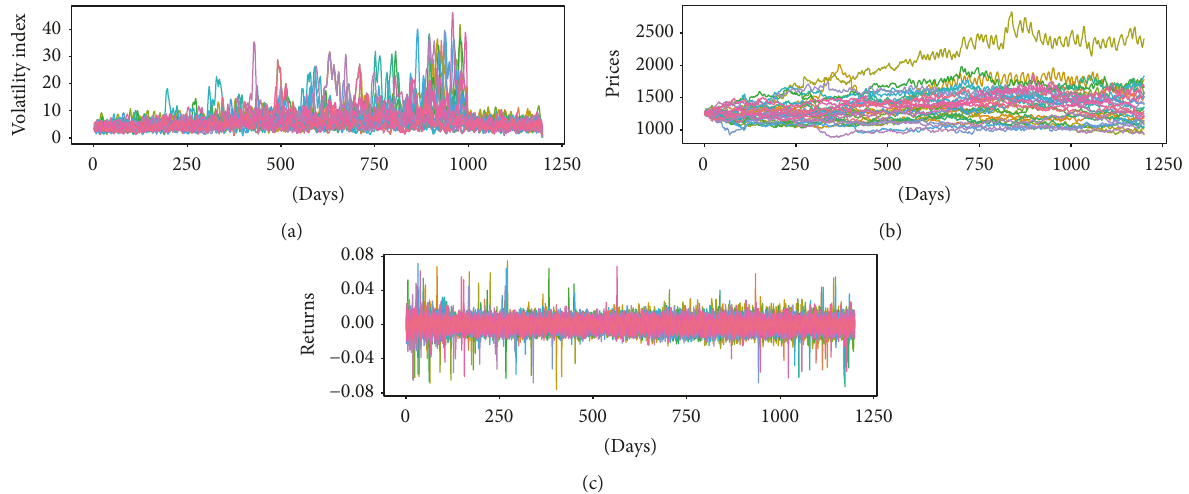
Figure 7: Time series of volatility index (a), prices (b), and returns (c), when 𝑔 = 1 = 𝑔 = 2 = 𝑔 = 3 = 0 .